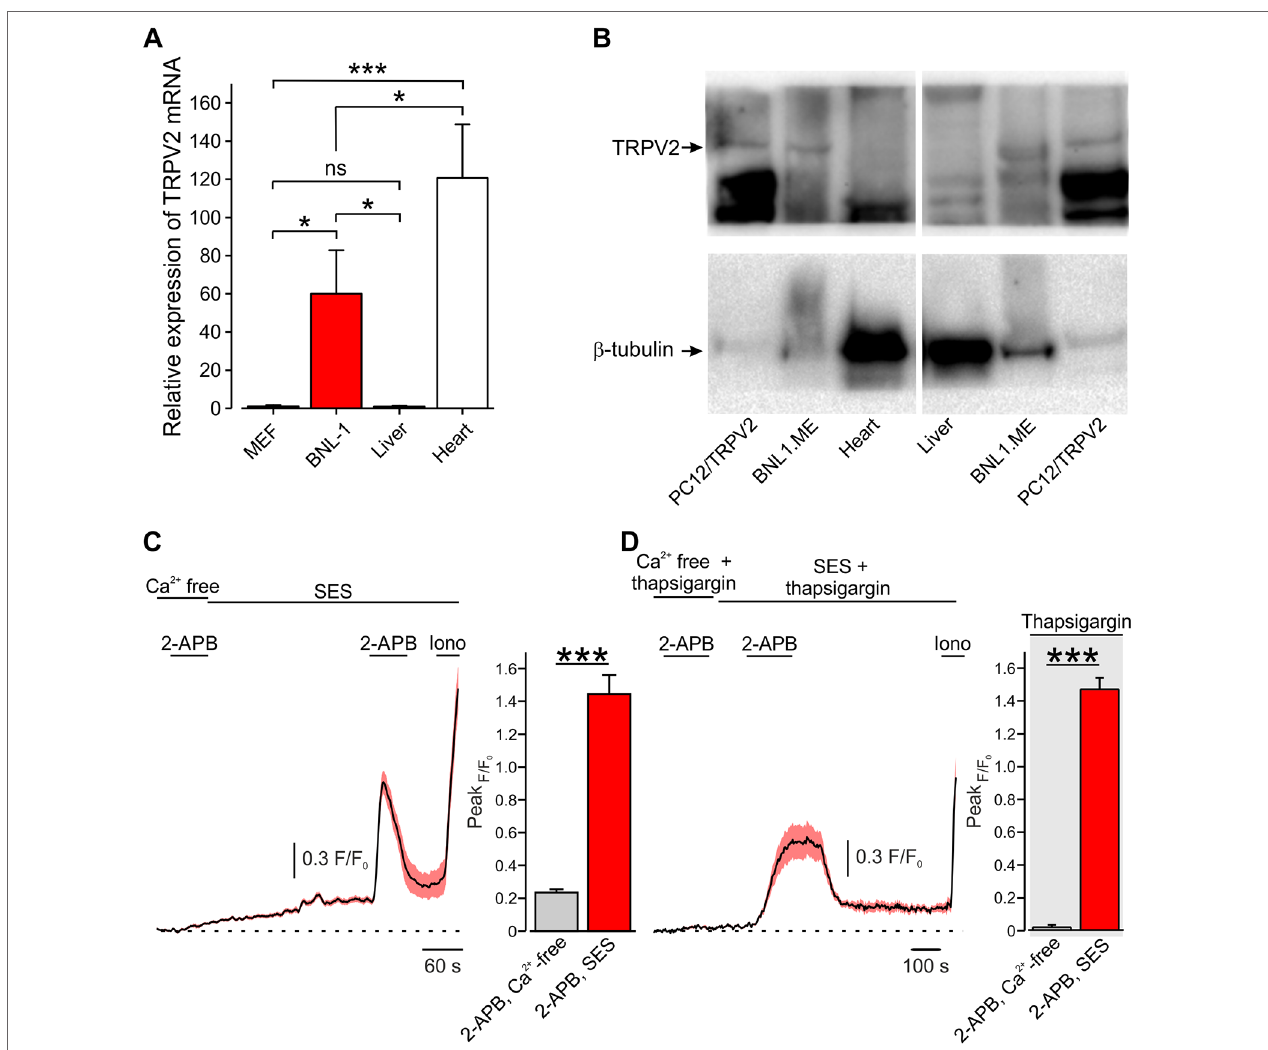
FIGURE 1 | Mouse hepatocellular carcinoma BNL1 ME cells, but not liver or heart cells express functional TRPV2 channels. (A) Bar graph depicting relative expression levels, assessed by RT-PCR, of TRPV2 mRNA in BNL1 ME cells compared to MEF, non-cancerous mice liver, and mice heart cells (GAPDH was used for normalization; see Methods ). *—p < 0.05; ***—p < 0.001, one-way ANOVA with post hoc Bonferroni, n = 3 replications. (B) Western blot analysis of TRPV2 protein levels in BNL1 ME cells compared to pheochromocytoma 12 cell line (PC12) constitutively expressing TRPV2 (PC12/TRPV2), non-cancerous mice liver cells, and mice heart cells. β -Tubulin served as a control (for a blot containing all the lanes; see Supplementary Figure 1 ). The size of the proteins (95 kD for TRPV2 and 51 kD for β -tubulin) was determined relative to pre-stained size markers. Representative of five experiments. (C) Left, Mean ± SEM of changes in cytosolic [Ca 2+ ] i following bath application of 200 μM 2-APB. Note that application of 2-APB leads to a small increase in intracellular Ca 2+ when external solution contains nominal Ca 2+ concentration (Ca 2+ free) but produces a substantial and significant (***—p < 0.001, one-way ANOVA) increase in intracellular Ca 2+ when calcium is present in the bath solution (standard external solution, SES), n = 26 cells. For a positive control of imaging, 1 µM ionomycin (Iono) was added to the bath solution at the end of each experiment. Right, bar graph comparing peak changes in cytosolic [Ca 2+ ] i following application of 2-APB in Ca 2+ free-solution with changes in cytosolic [Ca 2+ ] i following application of 2-APB in 2 mM Ca 2+ containing SES; ***—p < 0.001, paired Student t -test, n = 43 cells, from three plates. (D) Same as in C , but with SES containing thapsigargin. Note that, under these conditions, the increase in intracellular Ca 2+ occurs only when calcium is present in the external solution (SES) n = 28 cells. Right, ***—p < 0.001, paired Student t -test, n = 34 cells, from three plates. ns, not